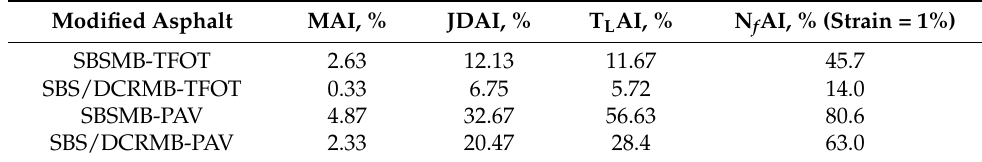
Table 4. Aging sensitivity of two modified